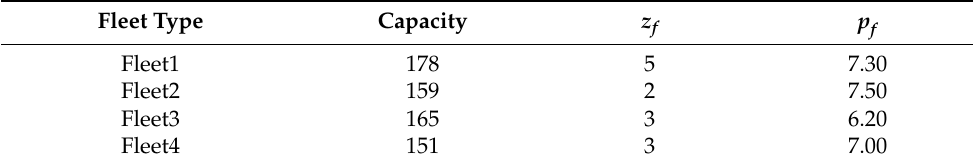
Table 2. Fleet data .